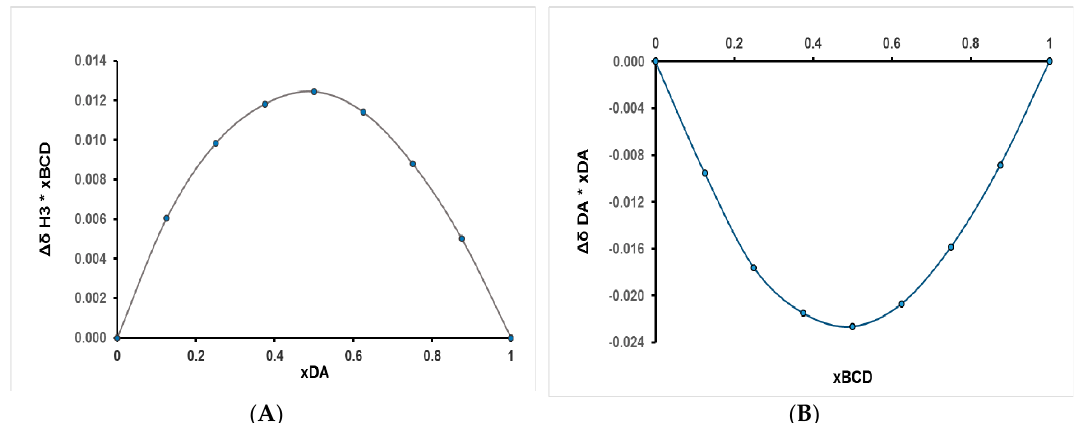
Figure 7. Job’s plots corresponding to chemical shifts variations of: ( A ) H-3 protons of β CD and ( B ) aromatic proton of DA from 7.82 ppm.